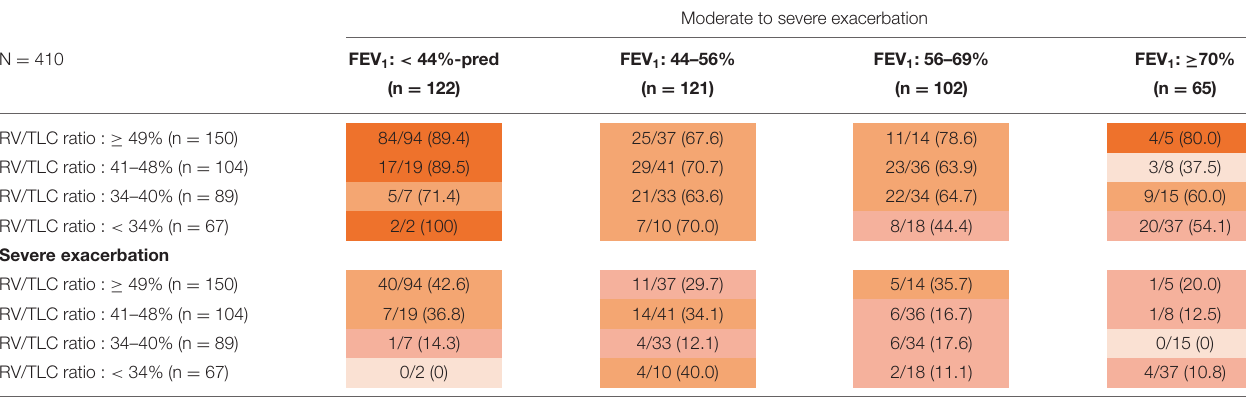
Moderate to severe